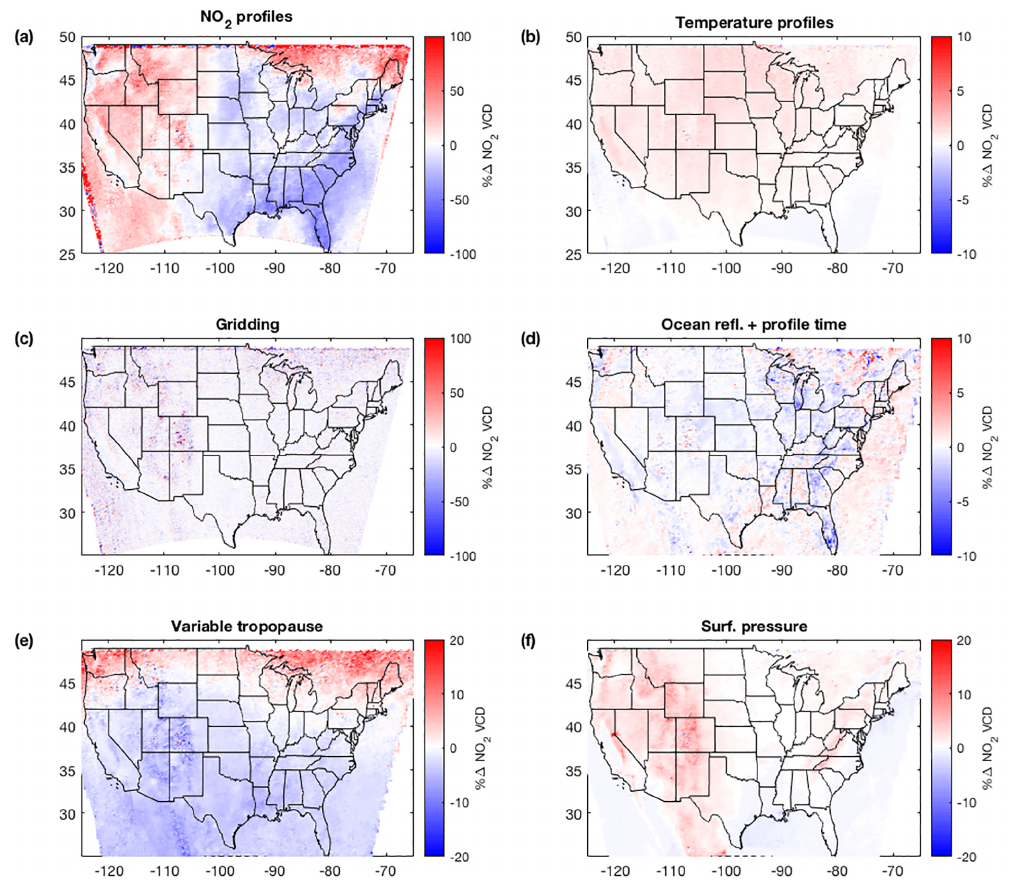
Figure 2. Percent change in the total tropospheric NO 2 column due to each of the algorithm improvements for the subproduct using daily profiles. Changes due to (a) new NO 2 profiles, (b) new temperature profiles, (c) new gridding, (d) change in profile time selection and ocean reflectance LUT from 430 to 460nm, (e) switch to WRF-derived tropopause pressure, (f) switch to the Zhou et al. (2009) surface pressure methodology. Note that in (a) , the difference is against an increment using monthly average profiles; also note that the color scale varies among the plots. Averages are for June–August 2012 and exclude pixels affected by the row anomaly and with cloud fraction > 0 . 2. Wintertime changes and histograms are given in Sect.